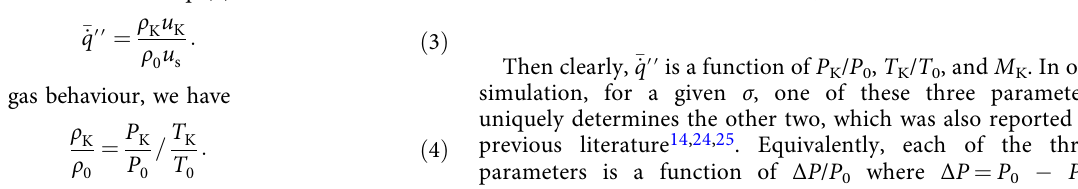
= 42.8 °C, P = 5.33 kPa with T = 33.7 °C and the yellow hexagrams are for T v v sat